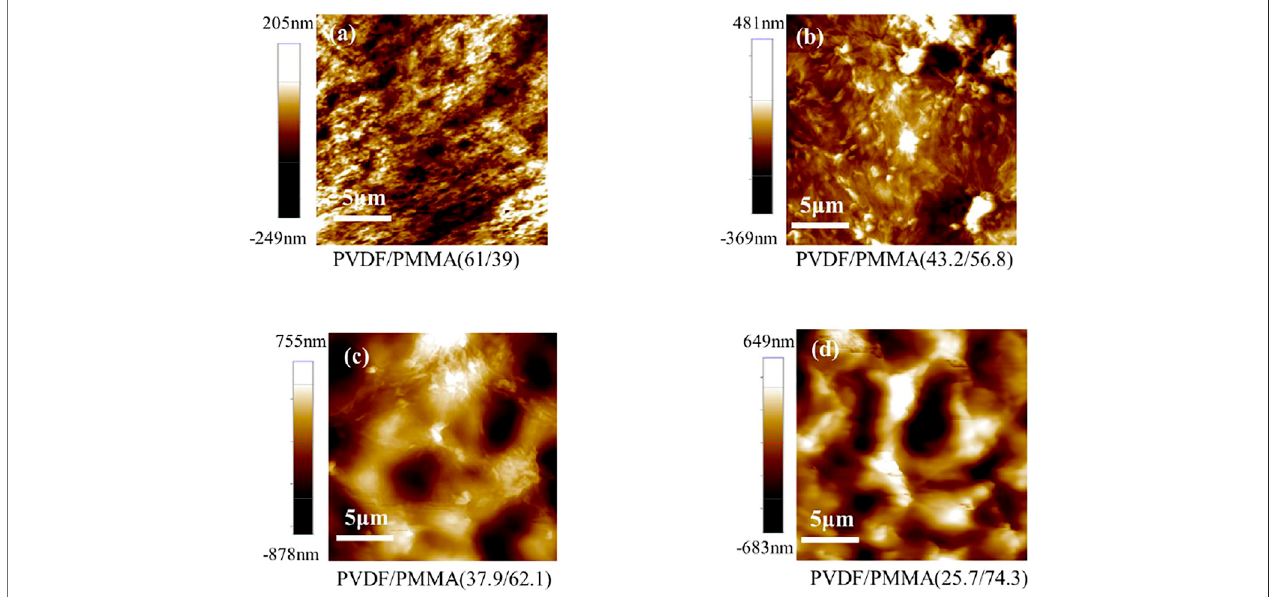
FIGURE 5 | K ( z ) values from SAXS of the blends with PMMA contents of (A) 0%, (B) 6%, (C) 19.5, and (D) 24.7%.